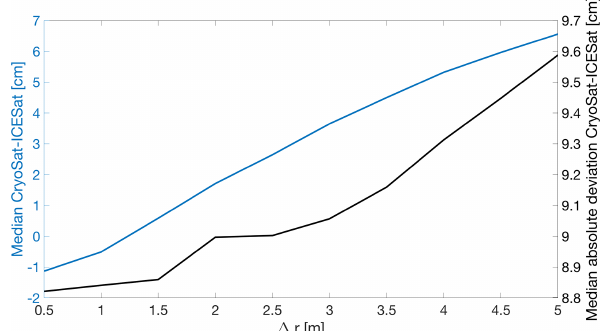
Figure 5. Median (left axis) and median absolute deviation (right axis) of the height differences between CryoSat-2 and ICESat-2 ( (cid:49)h calculated with Eq. 16) as a function of (cid:49)r . Outliers are re- moved using 10th and 90th